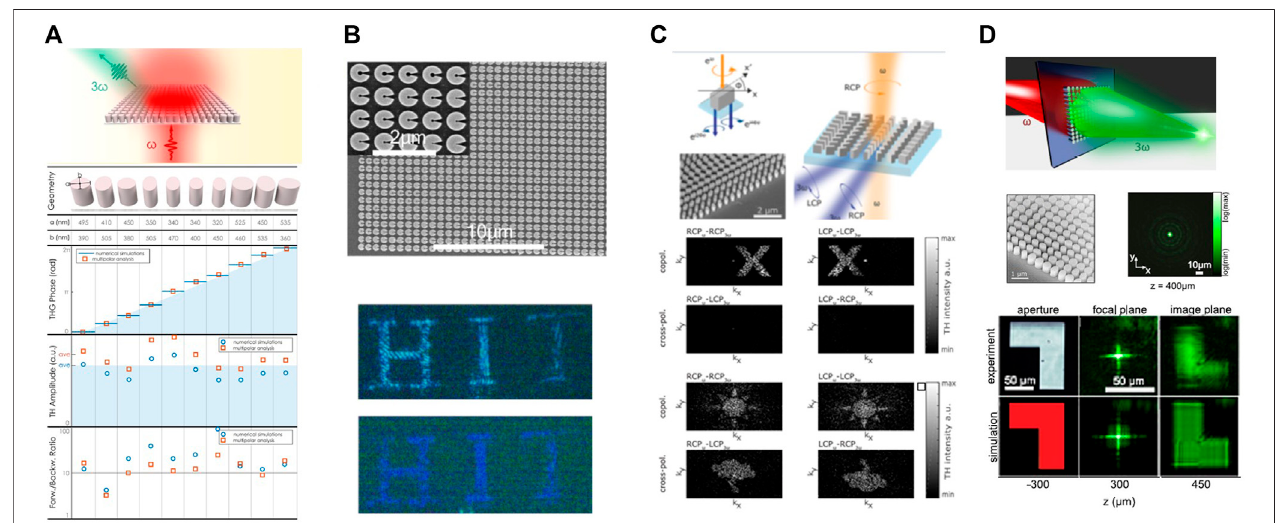
FIGURE 4 | Nonlinear THG process for wavefront control with silicon metasurfaces. (A) Nonlinear holography from the silicon nanopillar metasurfaces with the geometries, nonlinear phases, and TH amplitudes of nanopillar meta-atoms (Wang et al., 2018). (B) Nonlinear holography from the C-shaped Si nanoantenna-based metasurface with the SEM image and the experimentally obtained holographic images at 483 (top) and 417 nm (bottom) (Gao et al., 2018). (C) Nonlinear multiplexed holography from geometric-phase silicon metasurface with the working principle and the measured multiplexed holographic image (Reineke et al., 2019). (D) Nonlinear conversion and focusing of the fundamental Gaussian beam from silicon metalens with the SEM image and the measured TH intensity distribution of the focal spot, and the nonlinear TH image formation of the L-shaped aperture at an image distance of 450 um (Schlickriede et al.,